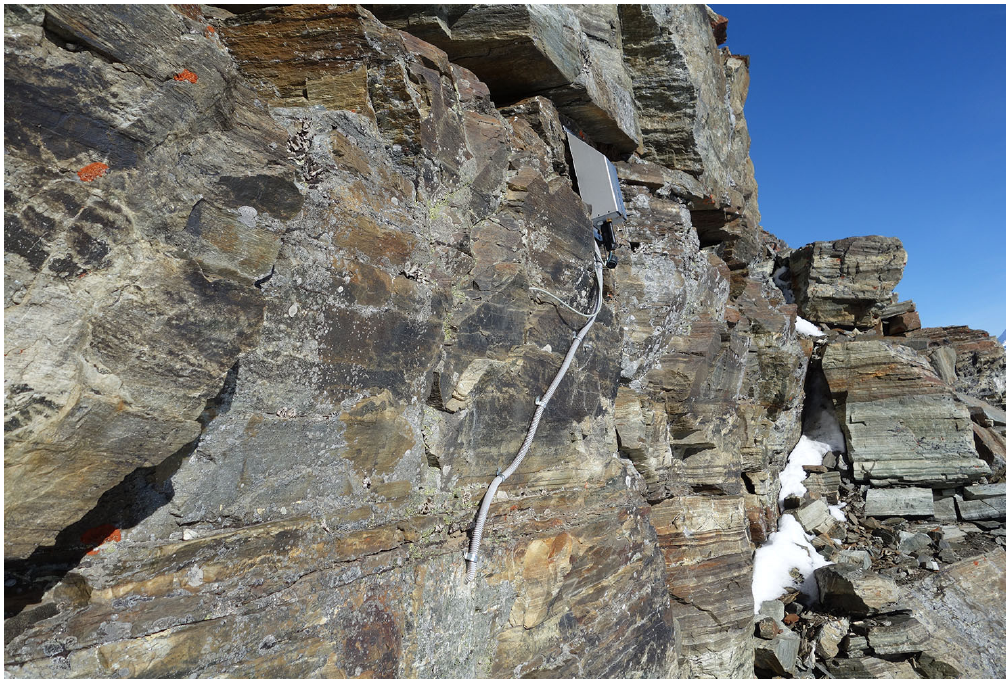
Figure C7. Rock temperature measurement at position MH10 on a south-exposed rock face.